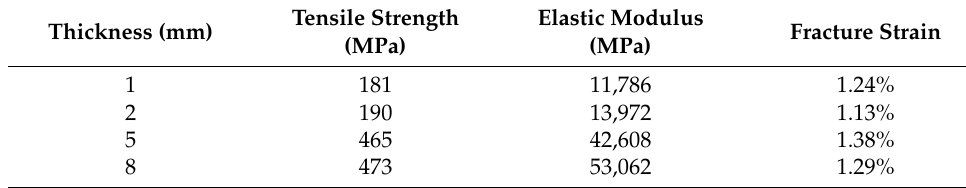
Figure 7. The material property test of GFRP tube. ( a ) The separation plate; ( b ) test process; ( c ) the GFRP coupon after the test. Table 9. Material properties of GFRP tubes.